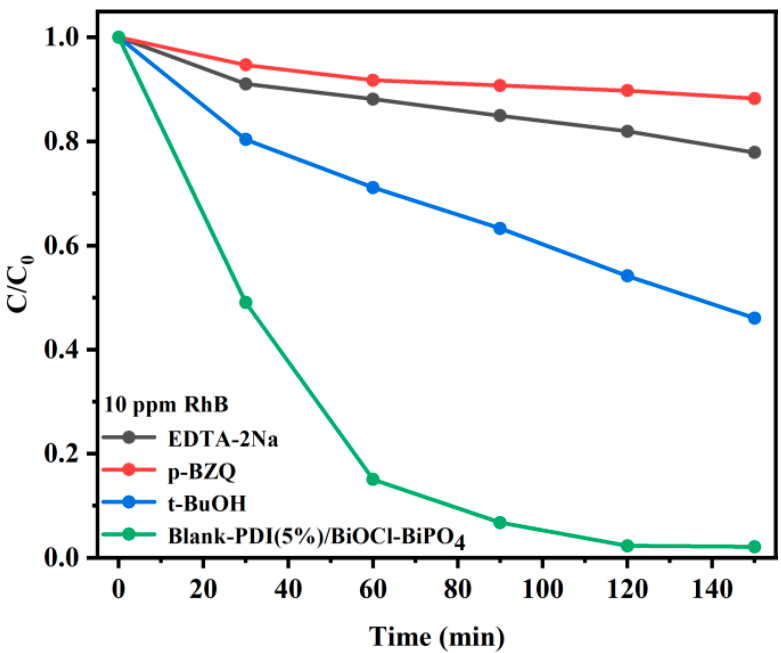
Figure 7. Active species trapping experiment of PDI(5%)/BiOCl-BiPO 4 sample in the photocatalytic reaction process.